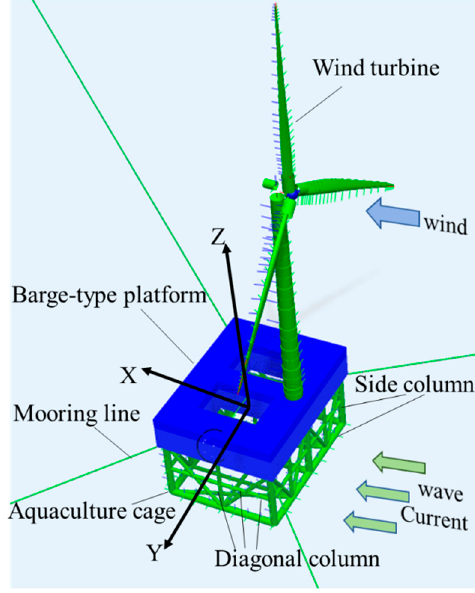
Figure 4. Illustration of the concept of LSBT-FOWT-AC. Table 2. Main parameters of the barge-type platform.